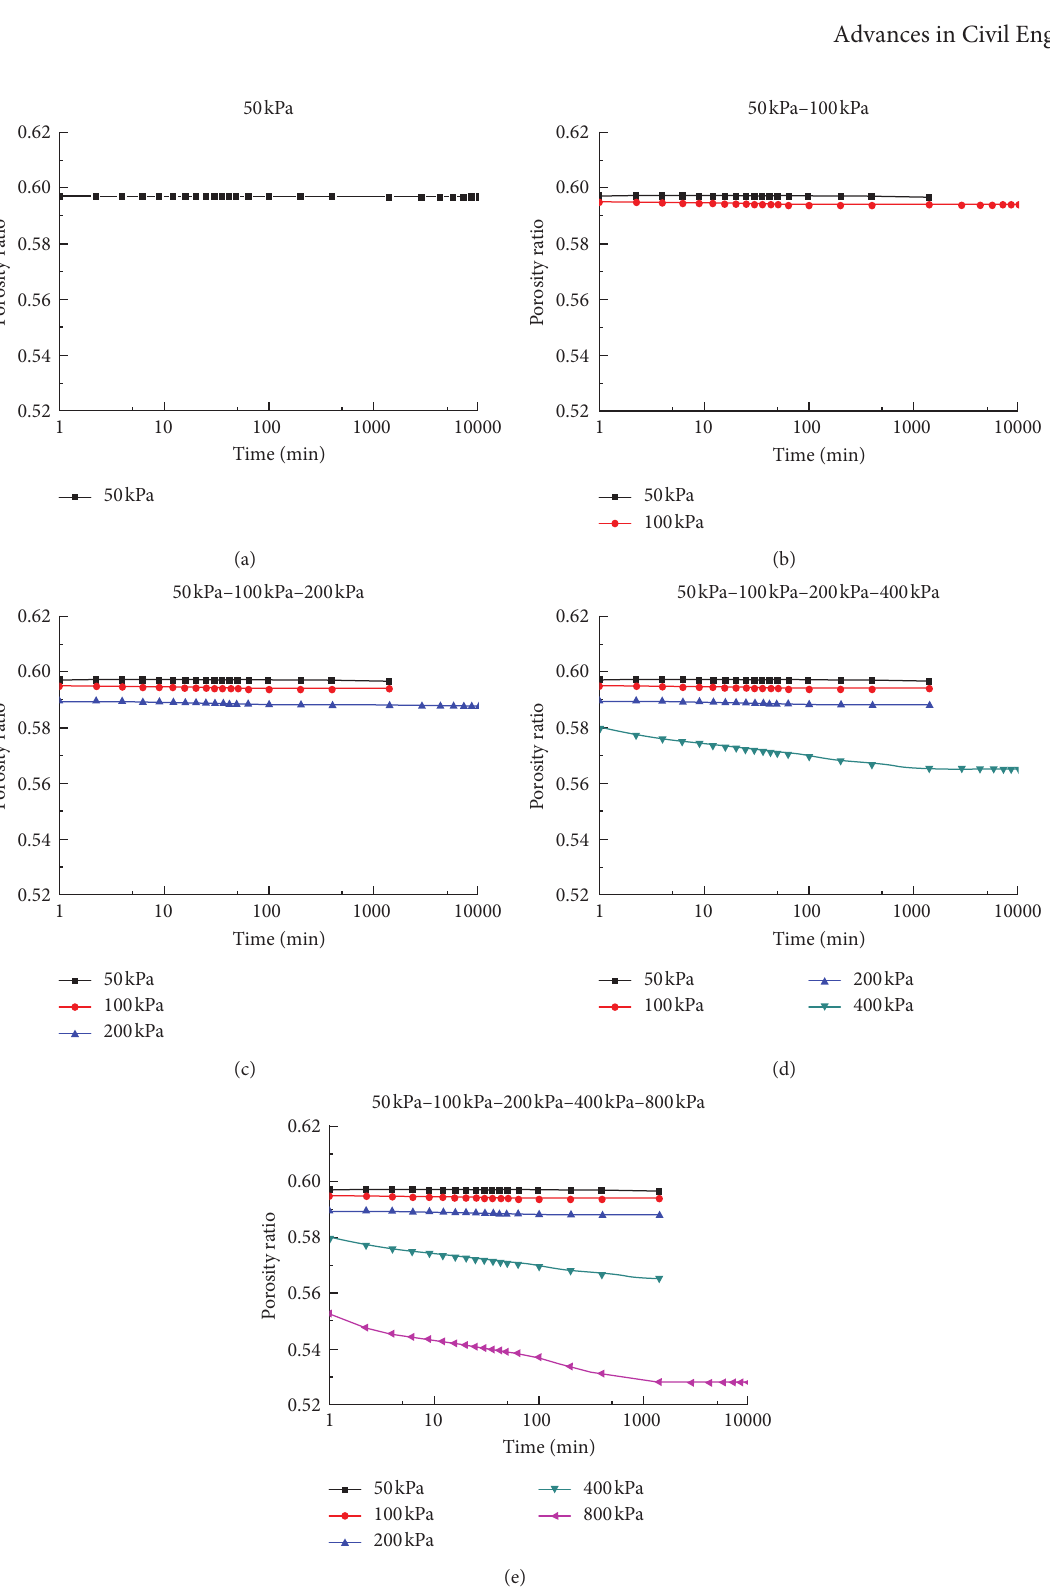
Figure 11: Consolidation test curve of expansive soil under the condition of preload of